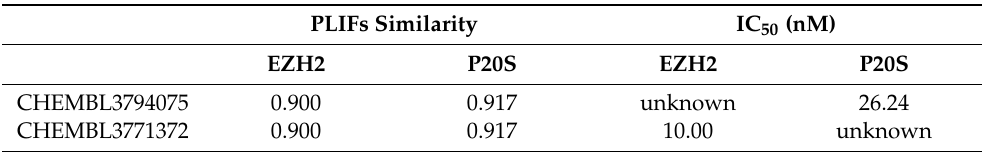
Table 1. Values of the similarity of the PLIFs between the selected molecules and the X-ray ligand, and the IC 50 values for the known